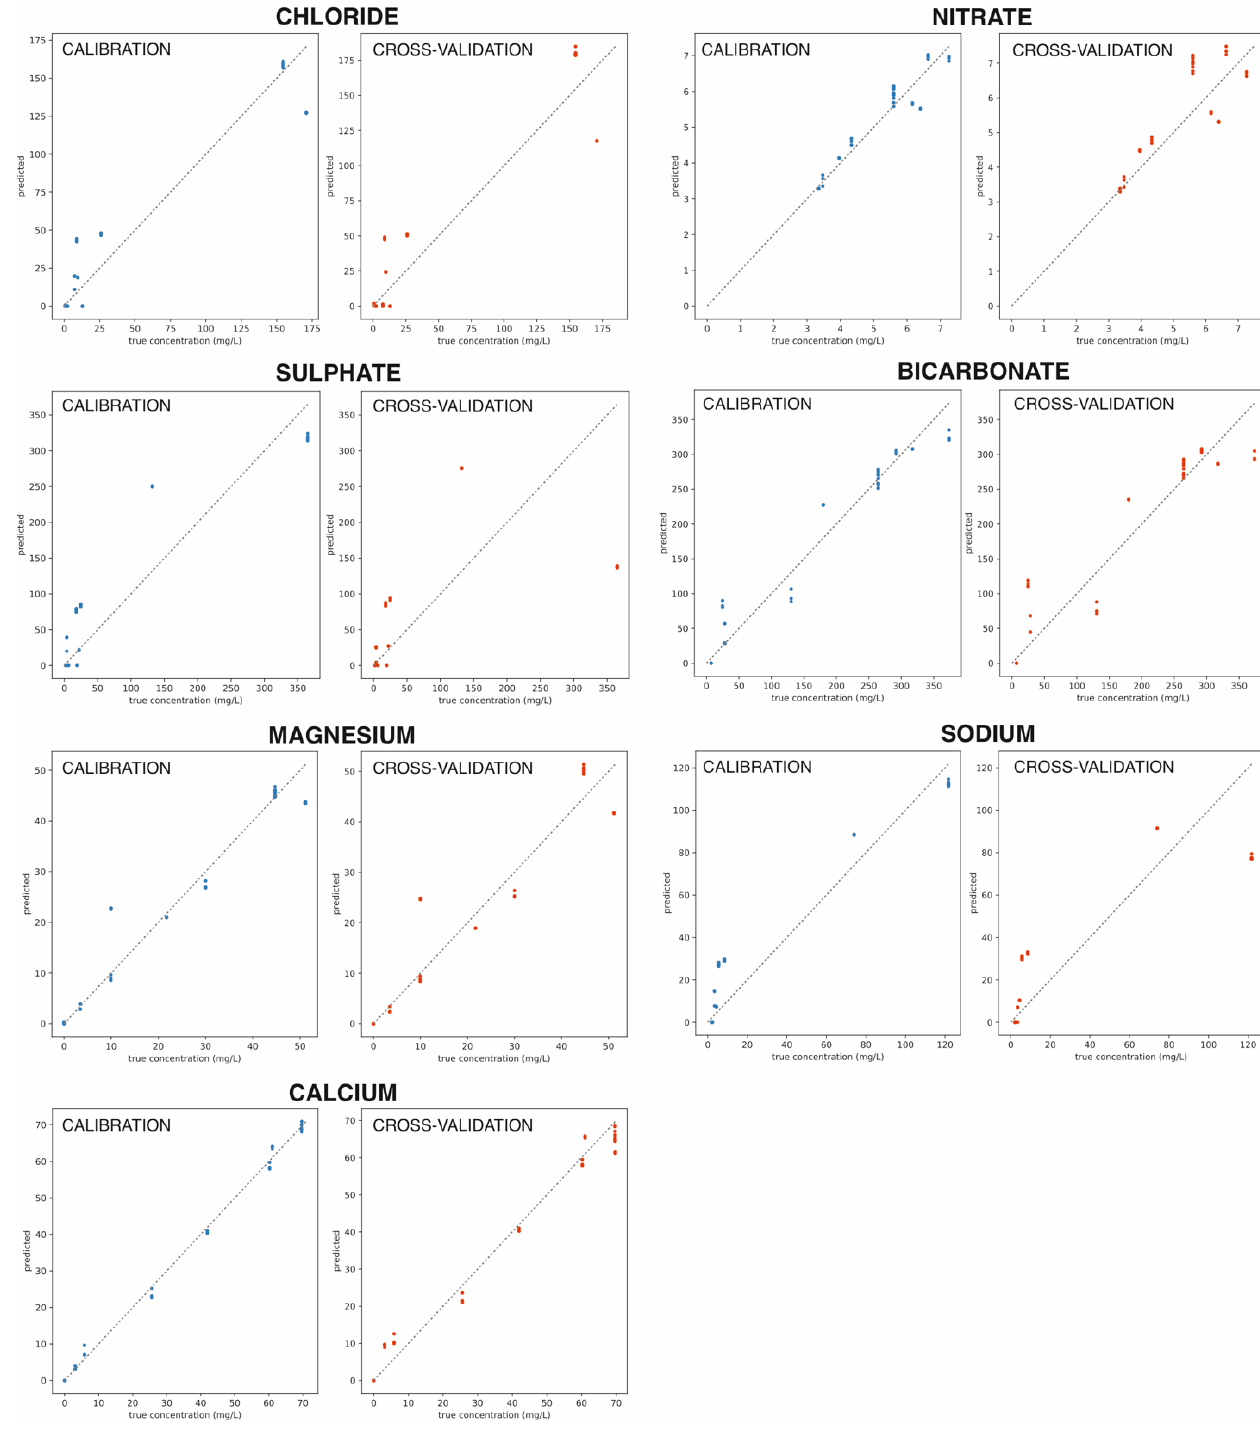
Figure 9. Calibration and cross-validation models (predicted versus true concentration values) obtained for all the ions tested in the mineral water samples.